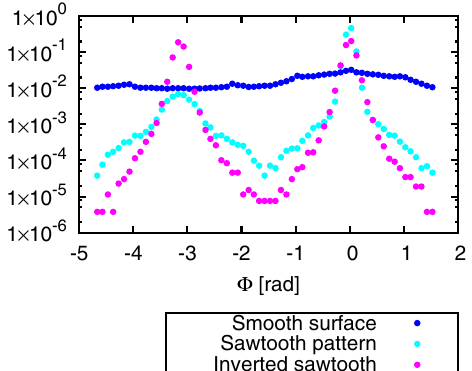
FIG. 4. Simulated azimuthal distribution (integral normalized to unity) of absorbed photons without (blue curve) and with a sawtooth (teal curve) and with an inverted sawtooth (purple curve)